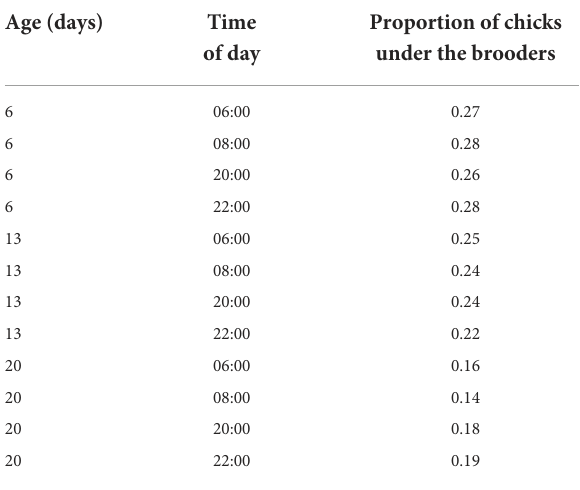
TABLE 1 Proportion of chicks being under the brooders during observation four times a day at ages 6, 13 and